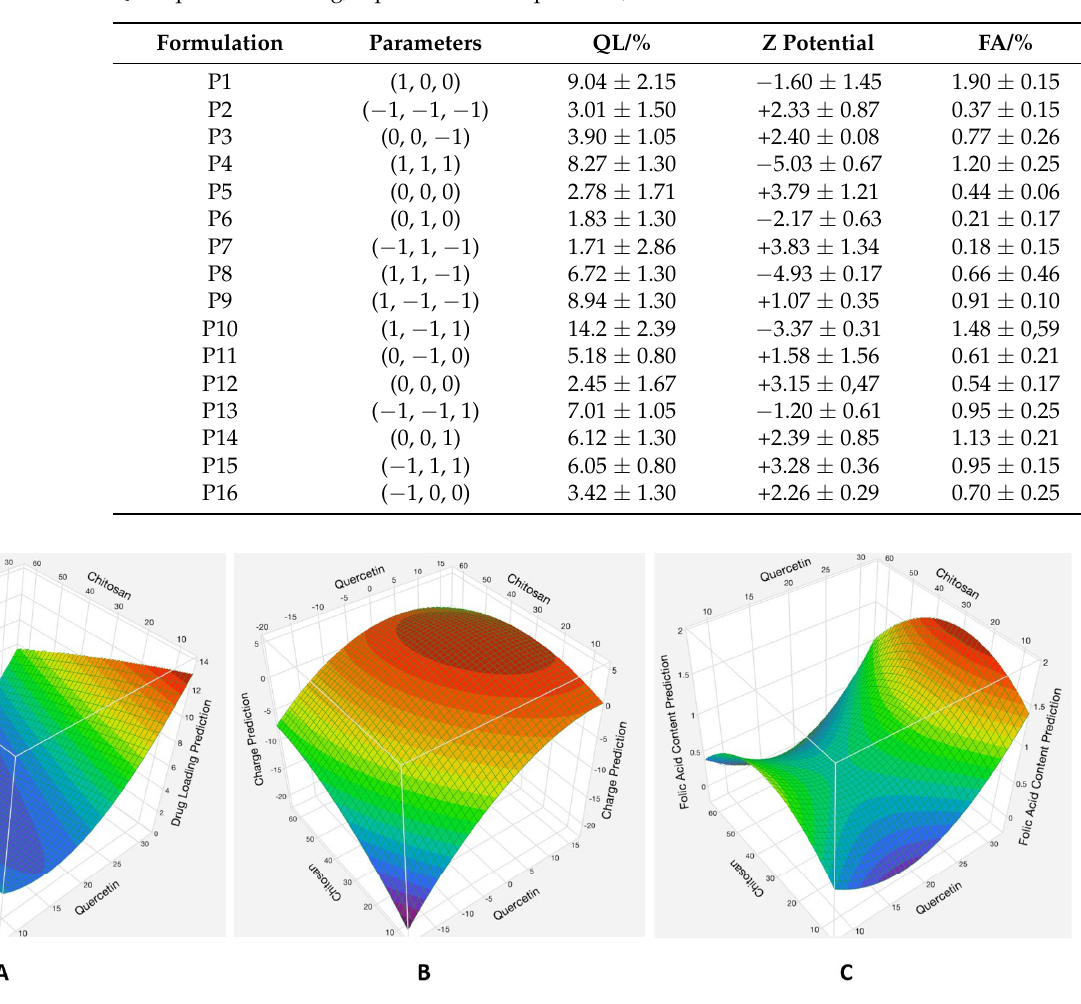
Figure 2. Response surface plots showing quercetin loading ( A ), charge ( B ), and folic acid content ( C ), variation with different quercetin and chitosan amounts. Amount of folic acid was kept constant at the intermediate value of 30 mg. Obtained from JMP